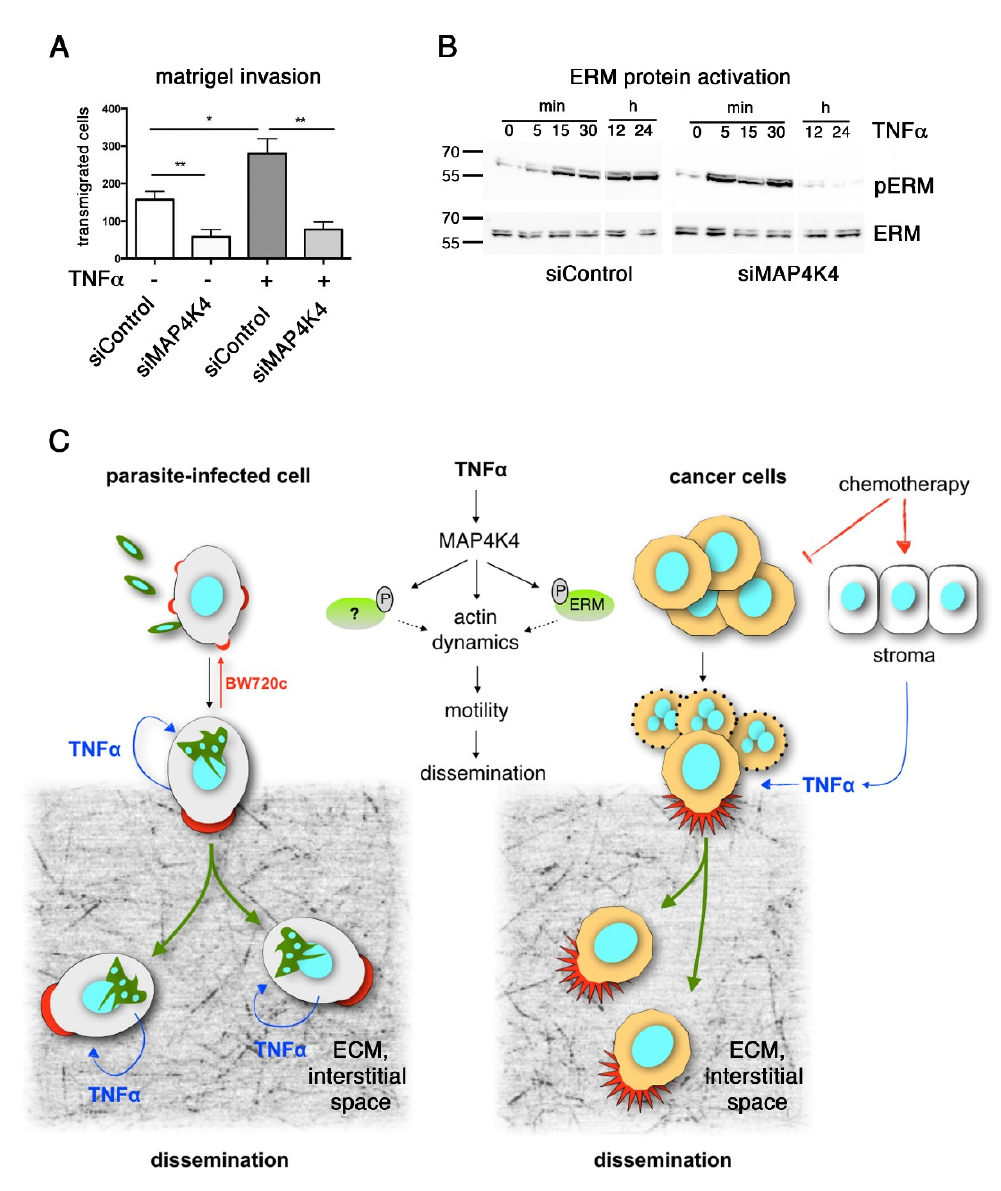
FIGURE 1: (A) Control and MAP4K4-depleted MDA-MB231 breast cancer cells were analyzed in Boyden chamber transwell matrigel invasion assay. TNFα stimulation (25 ng/ml) significantly increases matrigel invasiveness of MDA-MB231 cells. If the potential proto-oncogenic ser/thr kinase MAP4K4 is depleted, invasive cell motility is largely blocked both under unstimulated as well as under TNFα stimulated condi- tions. (B) The downstream effector proteins of the ERM family are activated (phosphorylated) in response to TNFα stimulation (25 ng/ml) in MDA-MB231. Depletion of MAP4K4 blunts their activation. (C) Schematic overview of the proposed mechanistic linkage between TNFα stimulation and invasive cell motility. ECM: extracellular